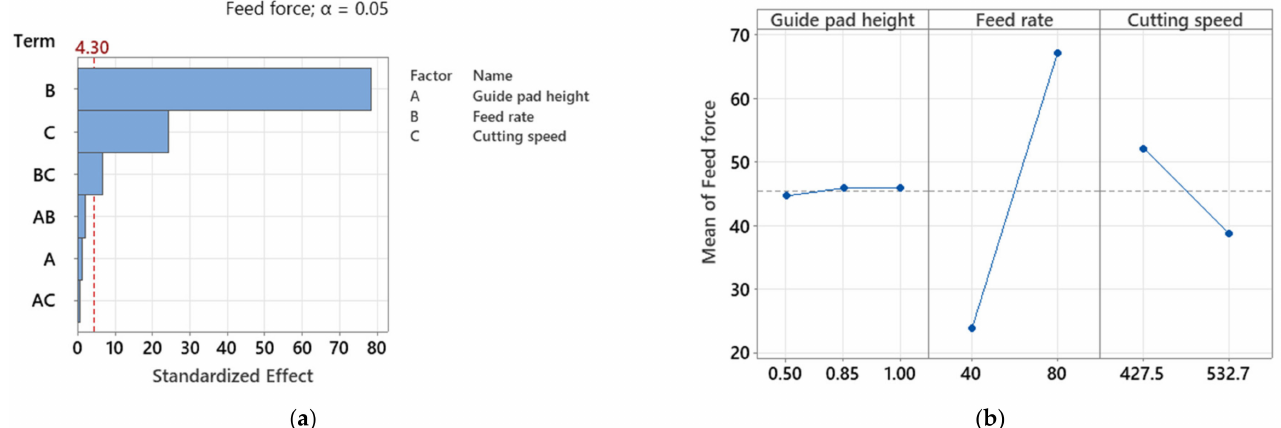
Figure 13. Pareto chart of the standardized effects for the feed force ( a ) and main effects plot for the feed force ( b